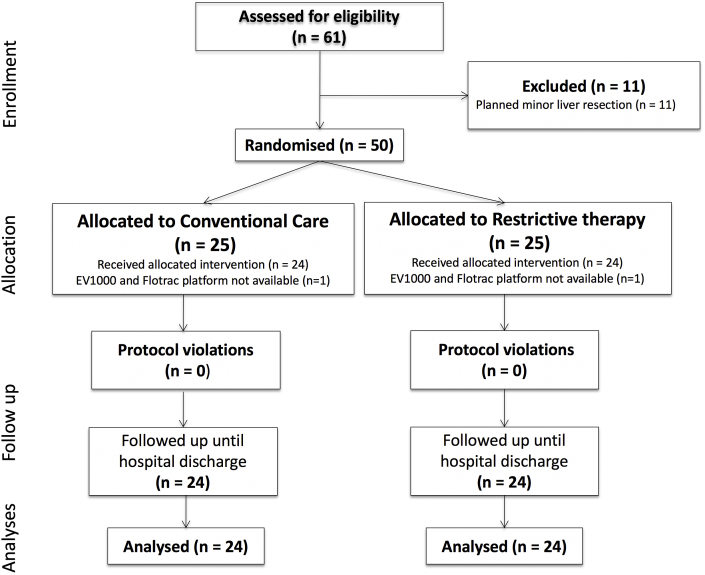
Consort diagram.